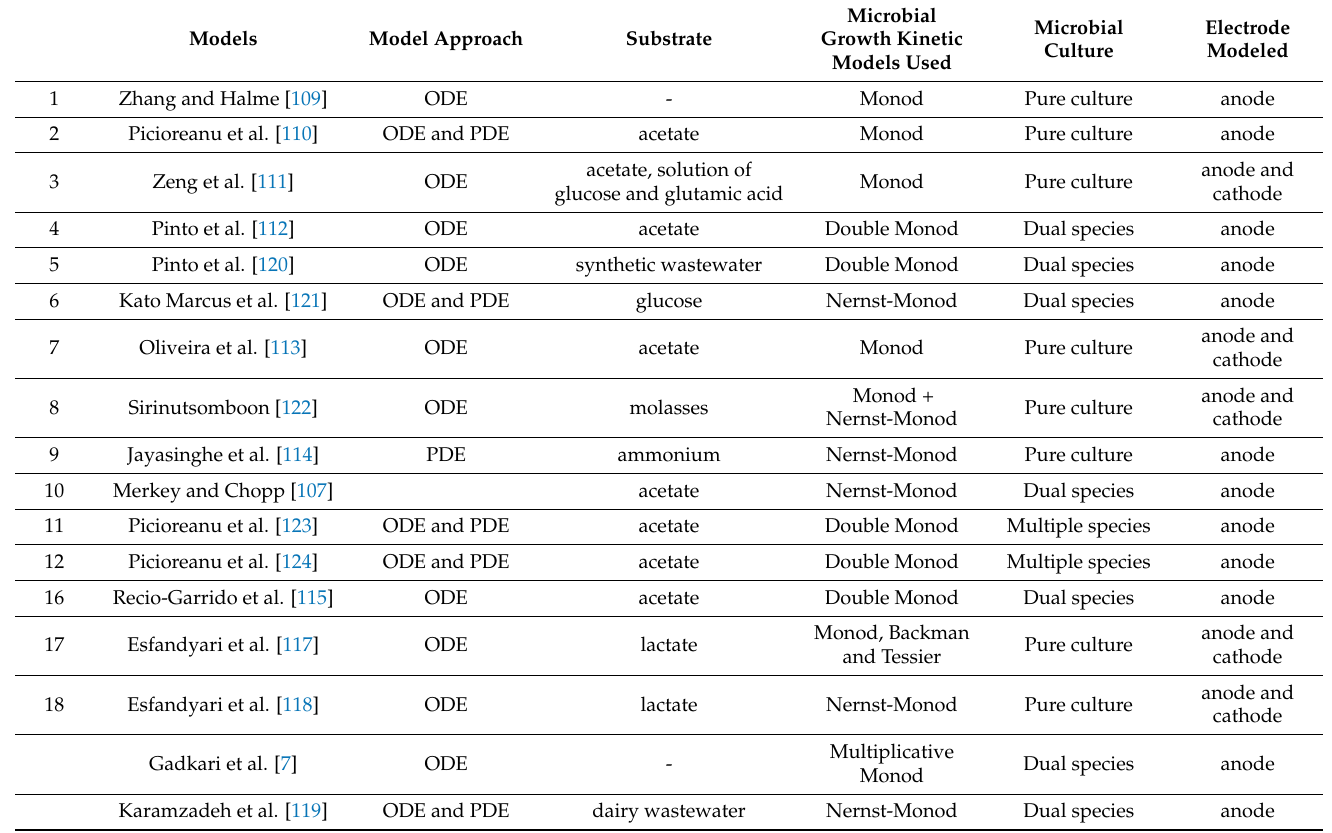
Table 2. MFC mathematical modelling approaches (from models, control, optimization); ODE and PDE: ordinary and partial differential